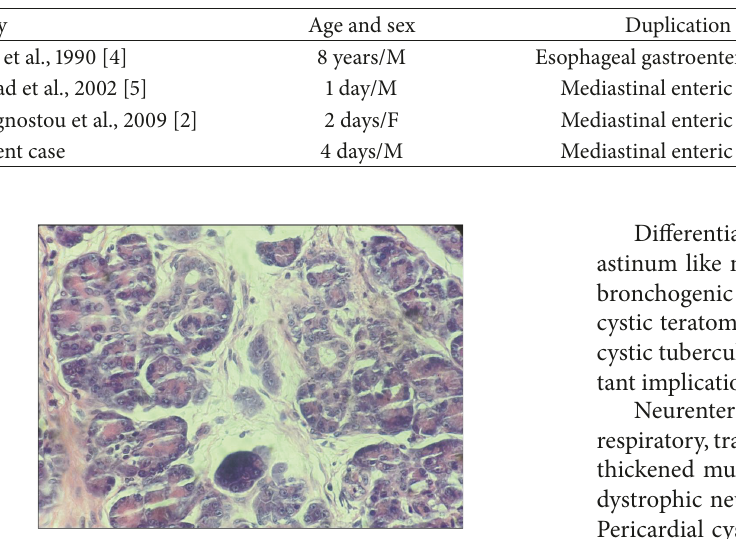
Figure 5: Microphotograph showing acini with cells having abun- dant eosinophilic granular cytoplasm (Hematoxylin & Eosin, 400x).